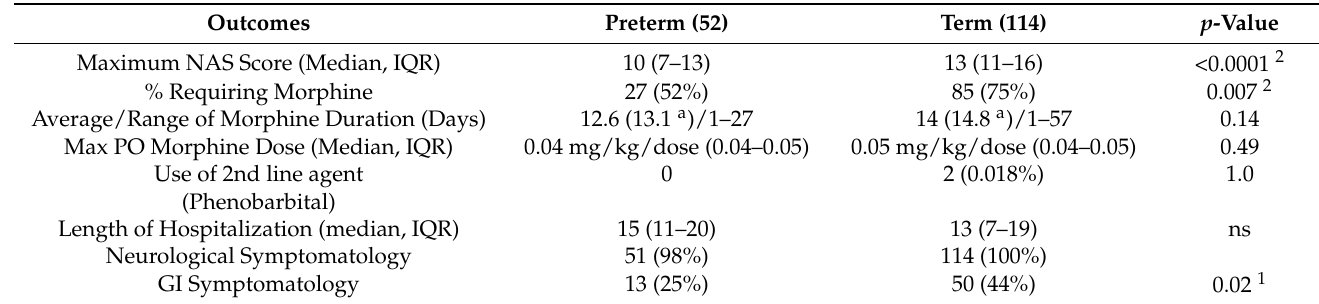
Table 2. NAS Outcomes and Symptomatology.